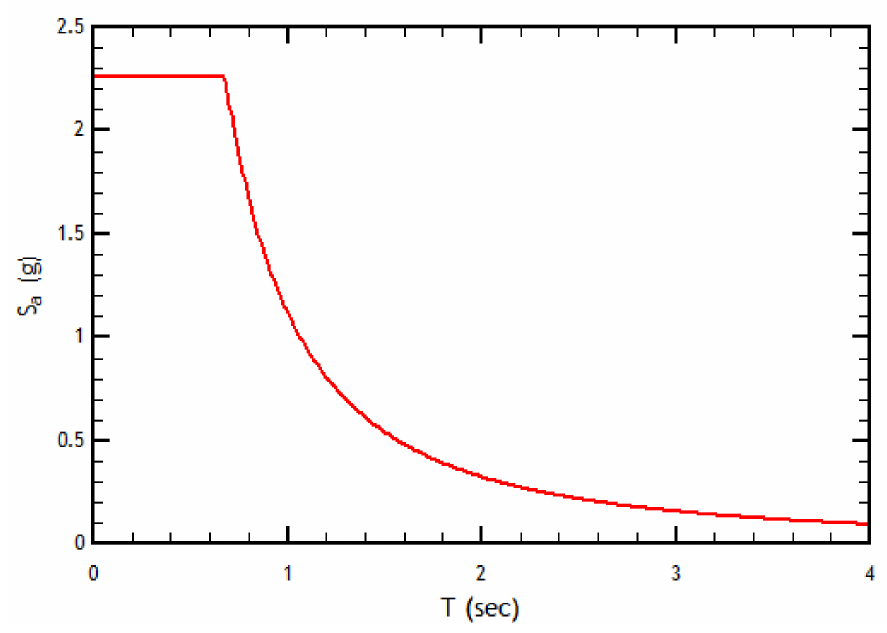
Figure 6. Design response spectrum according to the NCh2369